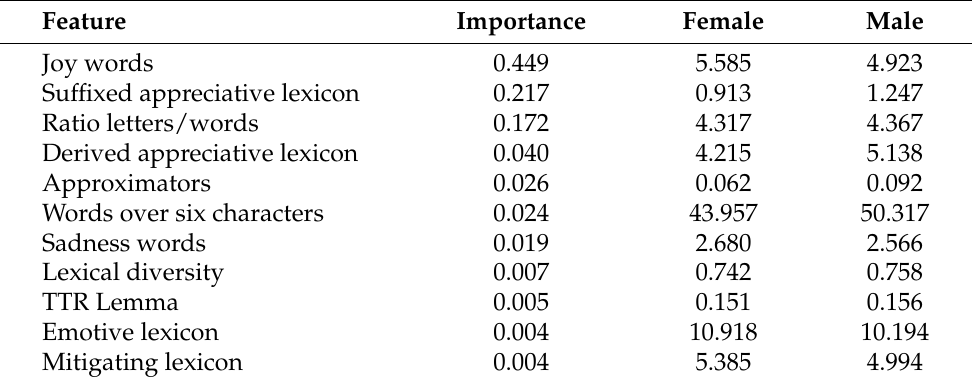
Table 6. Lexical feature importance and mean values.